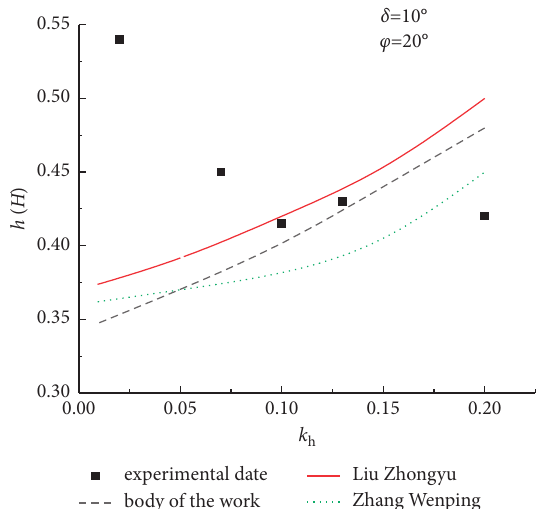
Figure 6: Comparison of experimental data and height of joint action point of different methods.